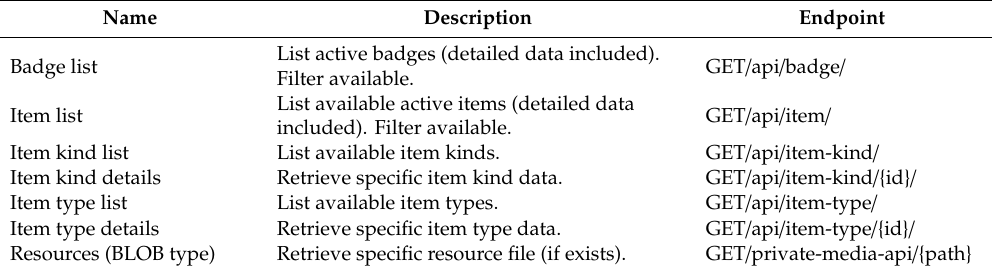
Table 3. Tour and user data endpoints.